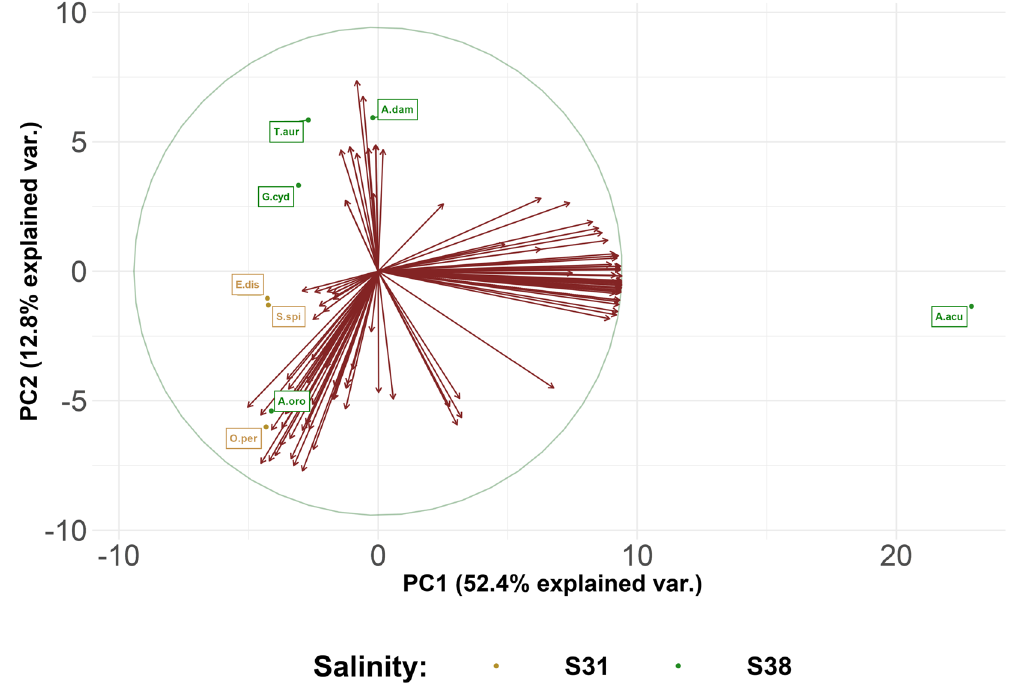
Figure 2. PCA analysis—Biplot of individuals (n = 8) and explanatory variables (n = 167) of two principal components (PC1 and PC2) of metataxonomic data. The majority of species diversity is explained by the first three PCs (76.7%), with PC1 and PC2 having the highest contribution (PC1 = 52.4% and PC2 = 12.8%). Biplot shows the PCA scores of the explanatory variables as vectors (in red) and individuals grouped for salinity class (S38 = Gulf of Naples, S31 = Strait of Messina). The circle represents the equilibrium of variables contribution. The importance of each variable is reflected by the magnitude of the corresponding values in the eigenvectors (higher magnitude-higher importance). Vectors pointing towards similar (small angle) and opposite directions (0 to 180 degrees) indicate positively or negatively correlated variables, and vectors at approximately right angles (90 to 270 degrees) suggest a low correlation. Sample IDs: O.per = Oceanapia cf. perforata , S.spi = Sarcotragus spinosulus , E.dis = Erylus discophorus , A.oro = Agelas oroides , T.aur = Tethya aurantium , A.dam = Axinella damicornis and A.acu = Acanthella acuta